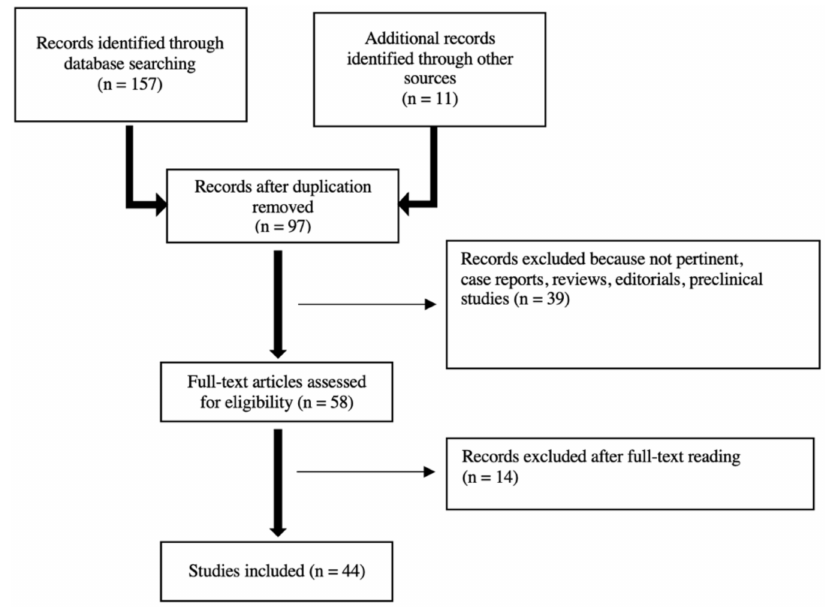
Figure 1. Studies’